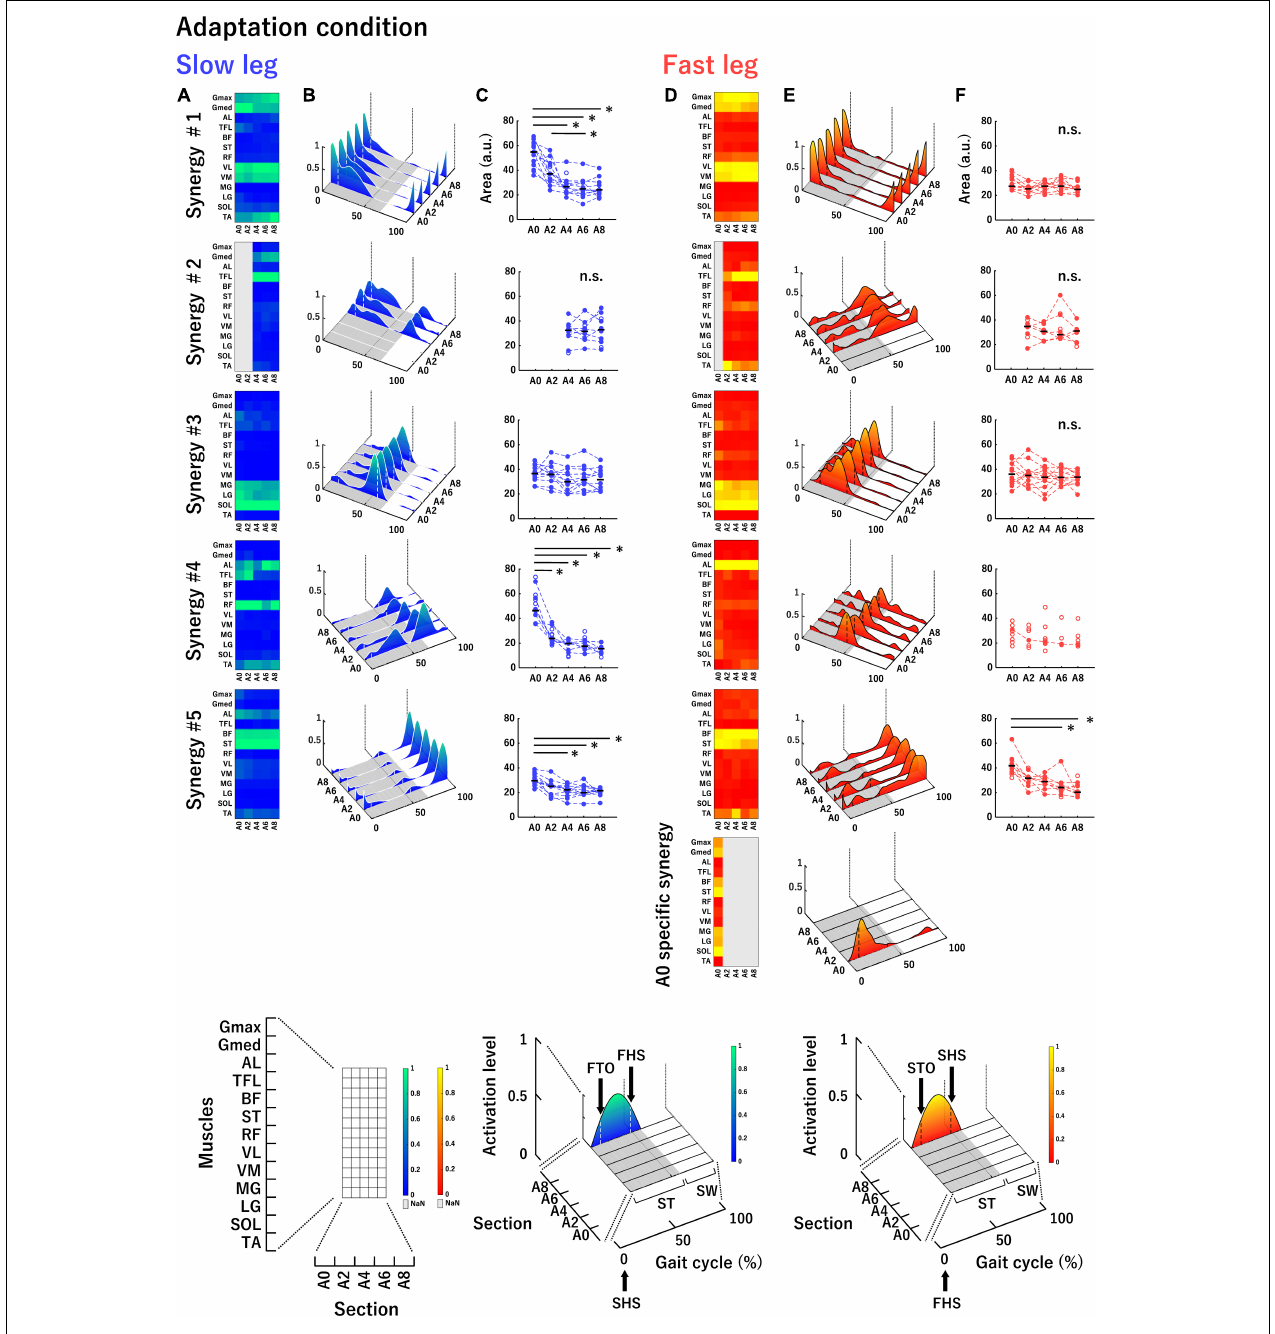
FIGURE 4 | Average muscle synergies across participants in the slow leg (A–C) and the fast leg (D–F) at each section in the adaptation condition. (A,D) Each heatmap represents the muscle weightings of muscle synergies. The vertical axis indicates muscle names, and the horizontal axis indicates sections. Bright color (green or yellow) indicates high weighting. The parts filled with gray in the heatmap mean that a corresponding muscle synergy was not extracted. (B,E) Each waveform represents the temporal activation patterns of muscle synergies. The vertical axis indicates activation level and the two axes in the bottom plane indicate sections and gait cycle (%). Bright color (green or yellow) indicates high activation. The bottom part of the figure, shown with gray, represents stance phase and the vertical white or black dotted lines depicted within the temporal activation patterns represent boundaries of the double support phase. An enlarged view of each axis of each heatmap and waveform is shown in the lowest row. (C,F) The areas under the curves of the temporal activation patterns of muscle synergies. The vertical axis indicates the area (a.u.) and the horizontal axis indicates the sections. The area of each participant is denoted by circles. The filled circles connected by dotted lines were used in the statistical analysis. Horizontal black bars indicate the median value across participants. n.s. indicates no significant difference in the one-way repeated measures ANOVA or Friedman test. ST, stance phase; SW, swing phase; FTO, fast leg toe-off; FHS, fast leg heel strike; STO, slow leg toe-off; SHS, slow leg heel strike. ∗ P <